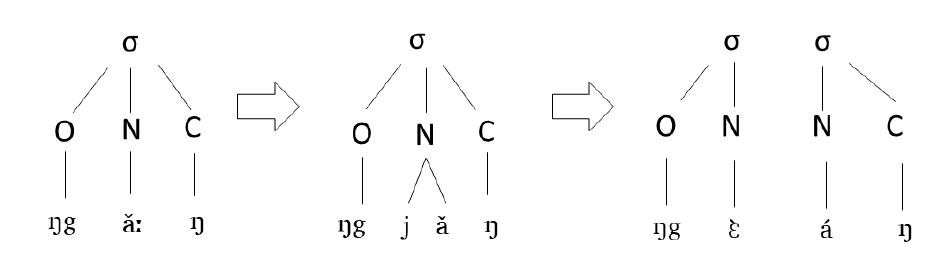
Figure 2 : creation of /ɛ.a/ sequences in